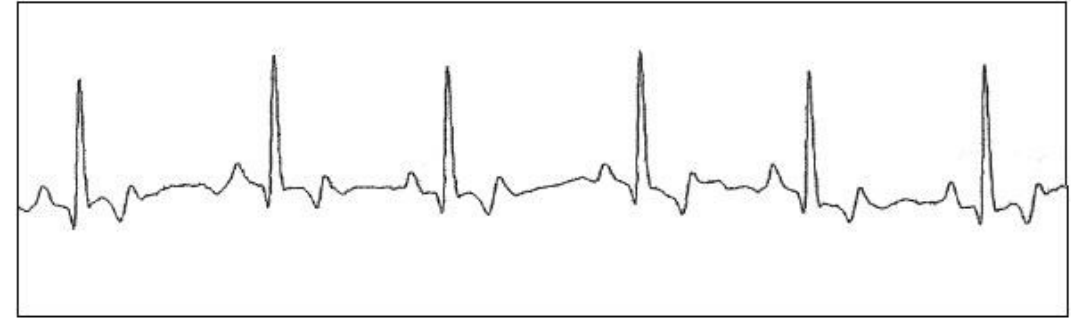
Figure 2. A normal electrocardiographic exam, with sinusal rhythm, from a male dog poisoned by